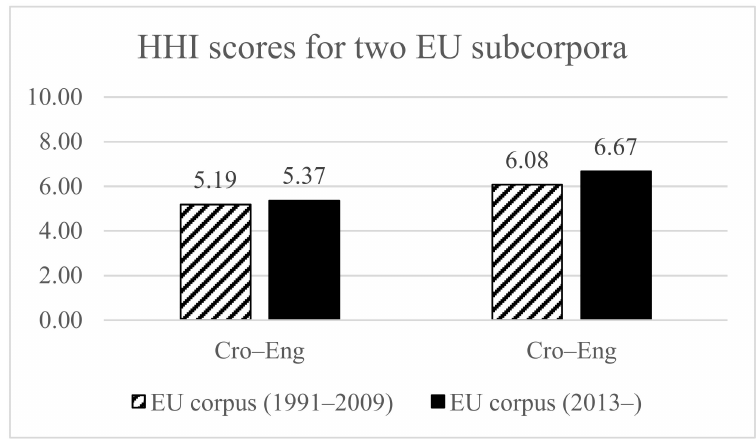
Figure 5. HHI scores for the later period subcorpus (EU corpus